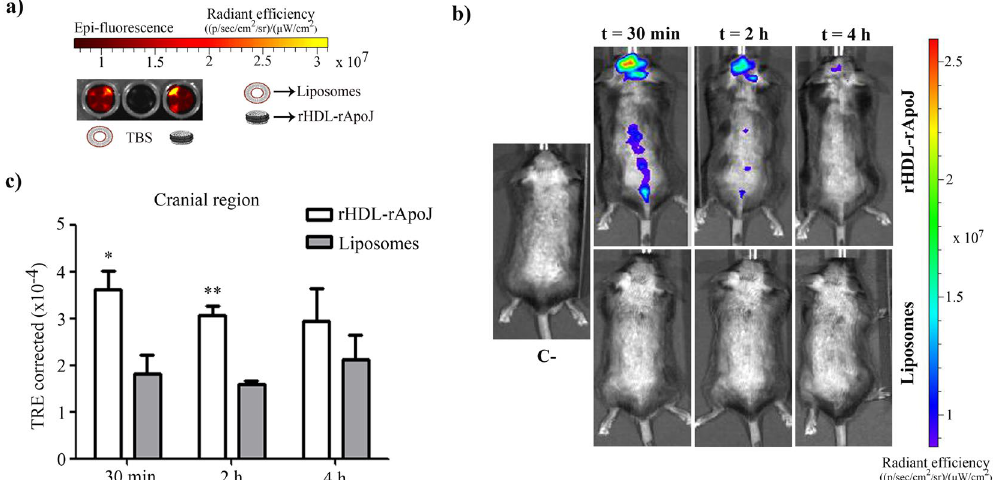
Figure 5. rHDL- rApoJ and liposome biodistribution in C57/BL6 mice. ( a ) IVIS Xenogen in vitro images of the epi-fluorescence of rHDL-rApoJ nanodisc and liposome preparations. (b) Representative in vivo IVIS Xenogen images of mice at 30 min, 2 h and 4 h after IV administration of labelled-rHDL-rApoJ or labelled-liposomes. C − = Non-treated control mouse. ( c ) Quantification of the fluorescent signal obtained in the cranial region after IV administration of labelled-rHDL-rApoJ nanodiscs or labelled-liposomes in 8 week-old C57/BL6 mice (N = 5–6/group). t-test analysis: * p < 0.05; ** p < 0.01 signal from rHDL-rApoJ nanodiscs compared to liposome treatment at each time-point.